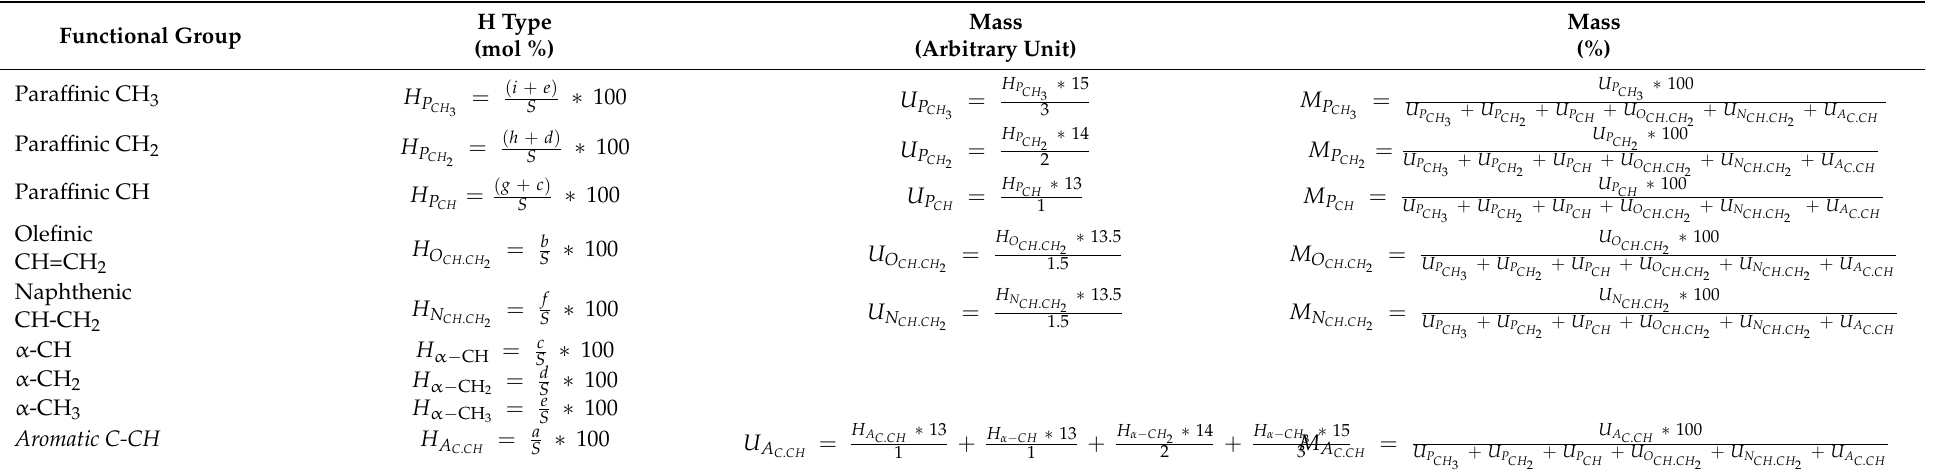
Table 2. Formulae for quantifying the hydrocarbon functional groups by mass